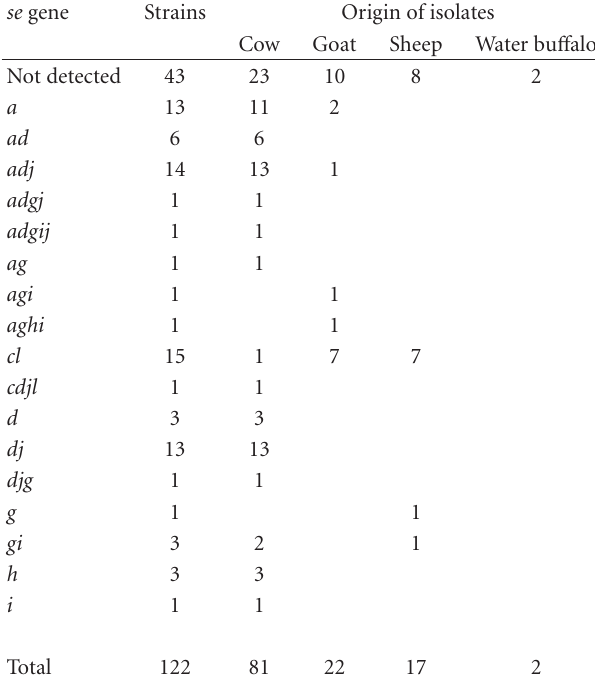
Table 2: Degree of heterogeneity among the se gene profiles of S. aureus